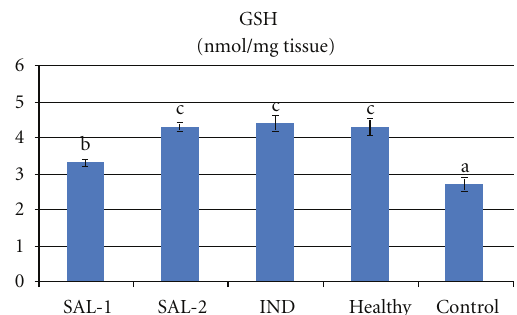
Figure 3: E ff ects of salbutamol (SAL) and indomethacin (IND) on myeloperoxidase (MPO) activity in carrageenan-injected paw tis- sues. Means in the same column by the same letter are not signif- icantly di ff erent and the means in the same column by di ff erent letters demonstrate significant di ff erences between the groups according to the Duncan test ( α = 0 . 05). In the above figure, the letter for the means in SAL-1 and IND columns is the same: “c.” This demonstrates that values in these lines are not statistically di ff erent from each other. However, the lines with the letter “c” are statistically significant from the lines with the letters “a,” “b,” and “d.”